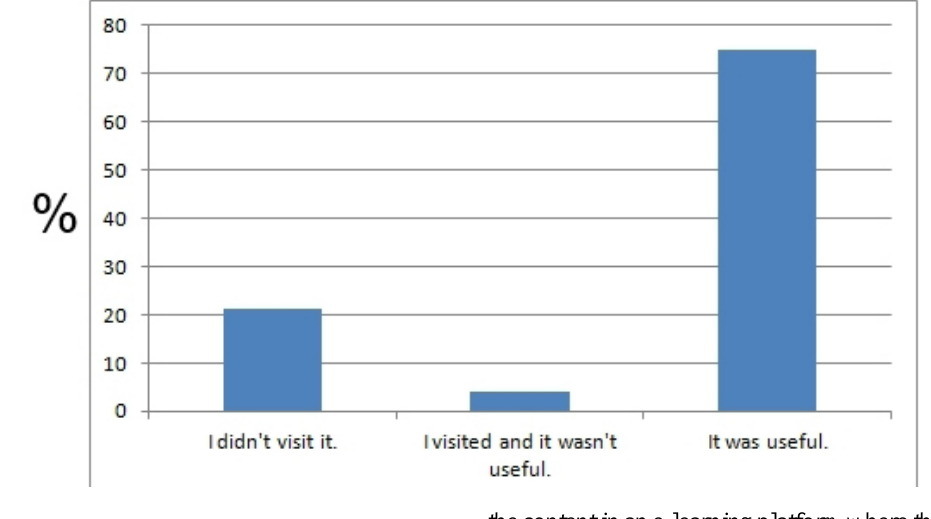
Figure 6. The number of students that visited the course website. The y axis represents the percentage of students that chose the particular